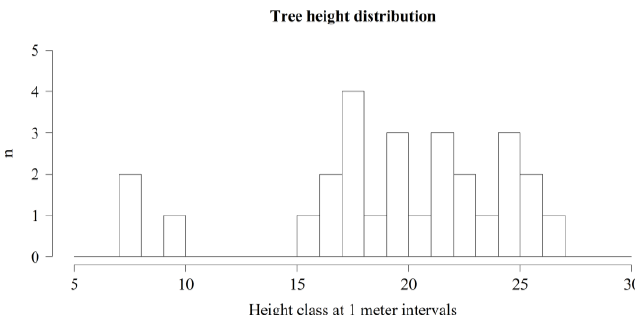
Figure 9. Tree-height distribution using maximum height of ALS points of tree crowns for the park area (northern part of the study